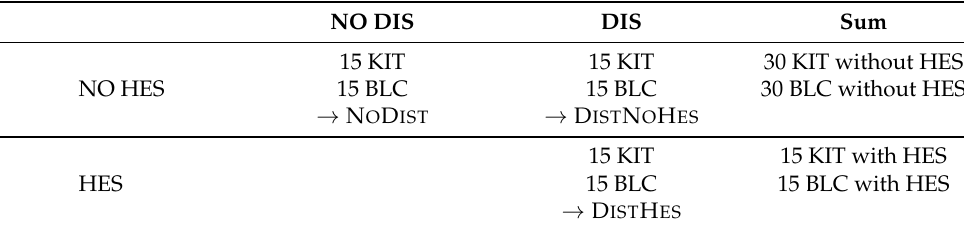
Table 1. Three conditions with a number of utterances utilized in the experiment (DIS: distraction, HES: hesitation, KIT: kitchen item, BLC: wooden block item). NO DIS DIS Sum 15 KIT NO HES